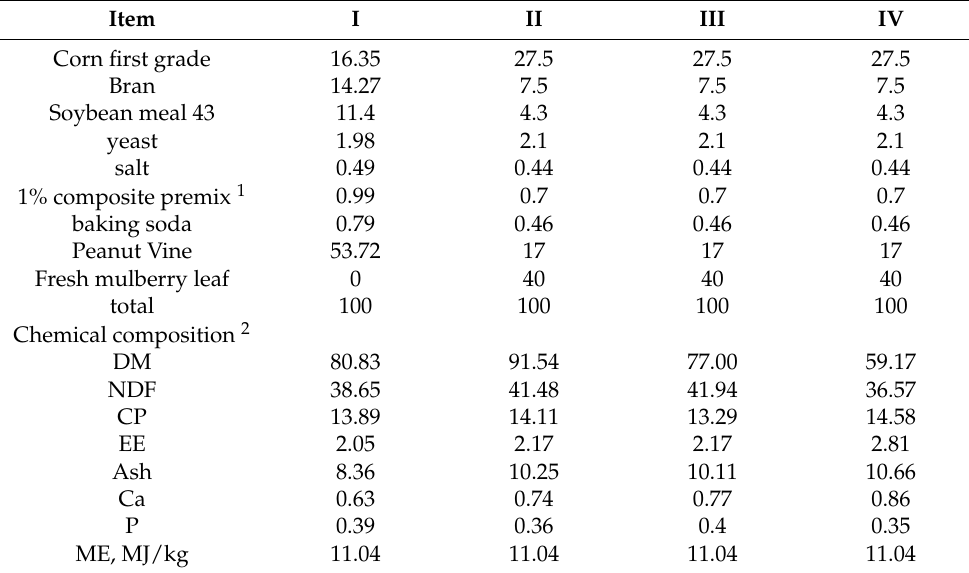
Table 1. Composition and nutrient levels of diets (%, air-dry